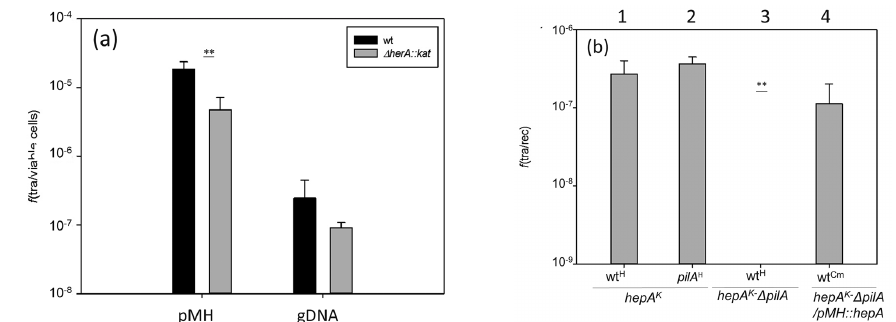
Figure 6. Effects of the absence of HepA in transformation and transjugation. ( a ) Parallel cultures of T. thermophilus HB27 gdh::kat (wt, black bars) and the Δ hepA::kat mutant (gray bars) were transformed with 150 ng of plasmid pMH118 or with 15 ng of genomic DNA from an isogenic strain labelled with Hyg resistance in the chromosome; and ( b ) transjugation assays between the indicated mates. (1) Δ hepA::kat × wild-type ::hyg ; (2) Δ hepA::kat × Δ pilA::hyg ; (3) Δ hepA::kat- Δ pilA double mutant × wild-